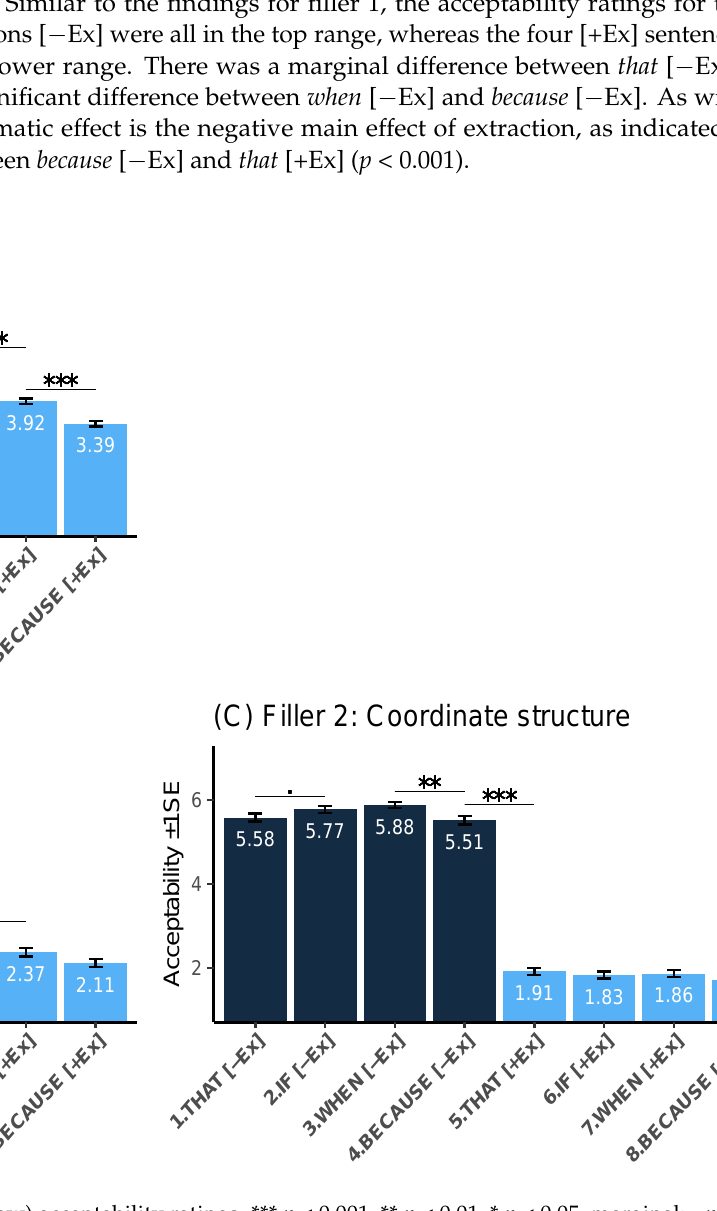
Figure 1. Mean (raw) acceptability ratings. *** p < 0.001, ** p < 0.01, * p < 0.05, marginal: · p <